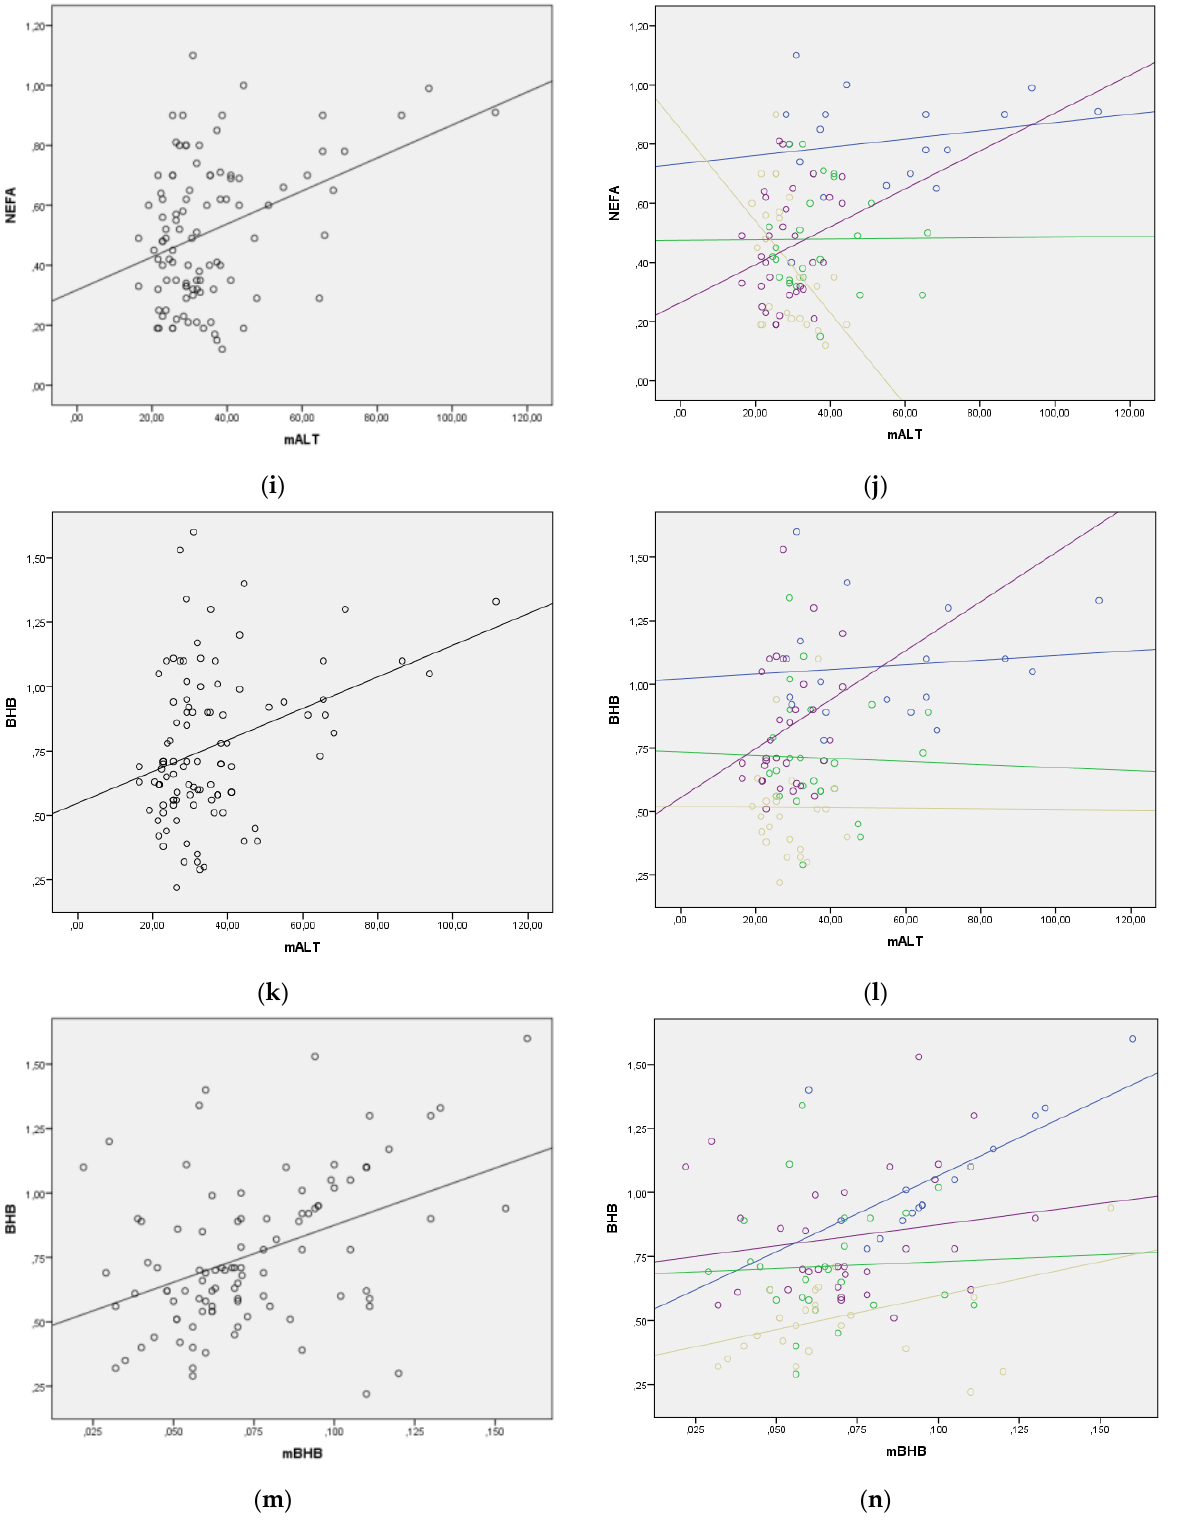
Figure 2. ( a – n ) Correlation between blood NEFA and BHB values and milk parameters with lactation period added as a covariate (lactation period and the color of both the line and the figures: early lactation-Group 1 — blue; full lactation-Group 2 — green; mid lactation-Group 3 — golden; late lactation-Group 4 — violet). ( a ) Correlation between milk fat and blood NEFA in whole lactation; ( b ) Correlation between milk fat and blood NEFA with lactation period as covariate; ( c ) Correlation between milk fat and blood BHB in whole lactation; ( d ) Correlation between milk fat and blood BHB with lactation period as covariate; ( e ) Correlation between milk AST (mAST) and blood NEFA in